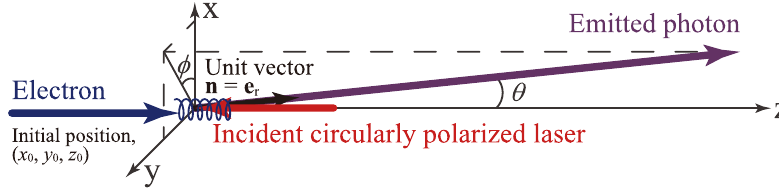
Figure 1. Coordinate system used in the